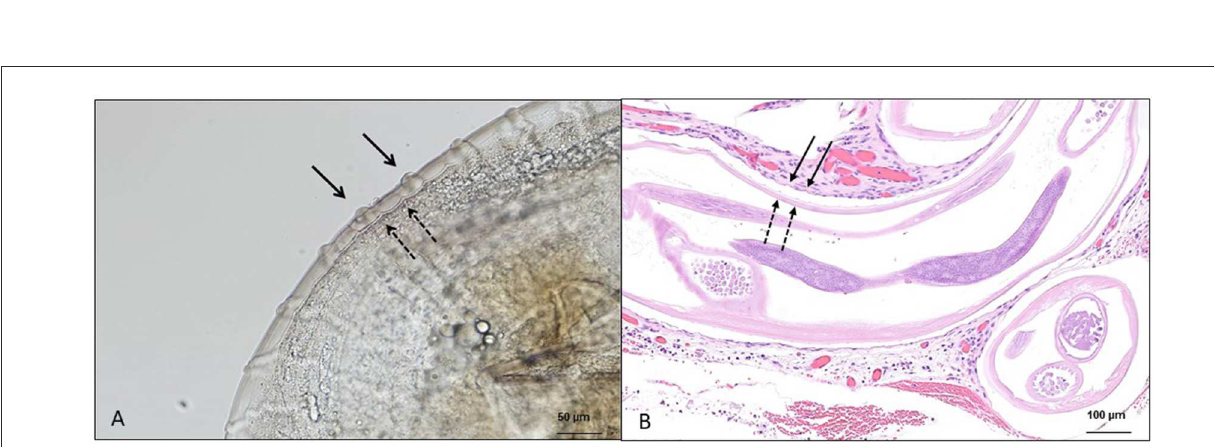
FIGURE2 Microscopic features of Onchocerca lupi adults. (A) Multilayered cuticle with prominent annular ridges, external surface (full arrow), and internal layer (dashed arrow); scale bar: 50 µ m. (B) Histological section of the ocular tissue of a dog with the presence of O. lupi , external surface (full arrow) and internal layer (dashed arrow); scale bar: 100 µ